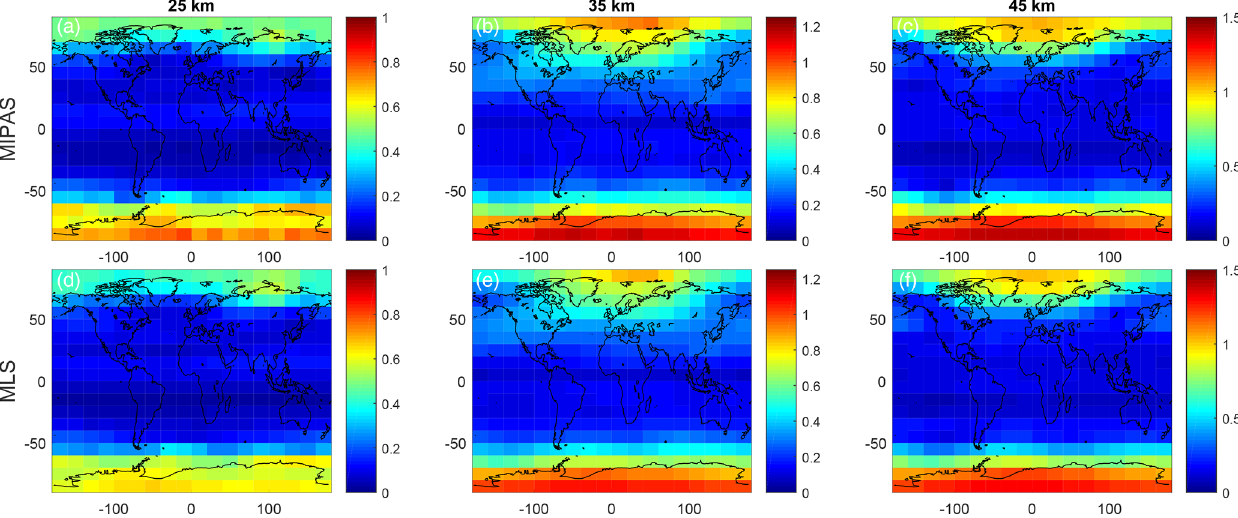
Figure 4. Relative amplitude of seasonal cycle at 25km (a, d) , 35km (b, e) and 45km (c, f) for MIPAS (a, b, c) and MLS (d, e, f)